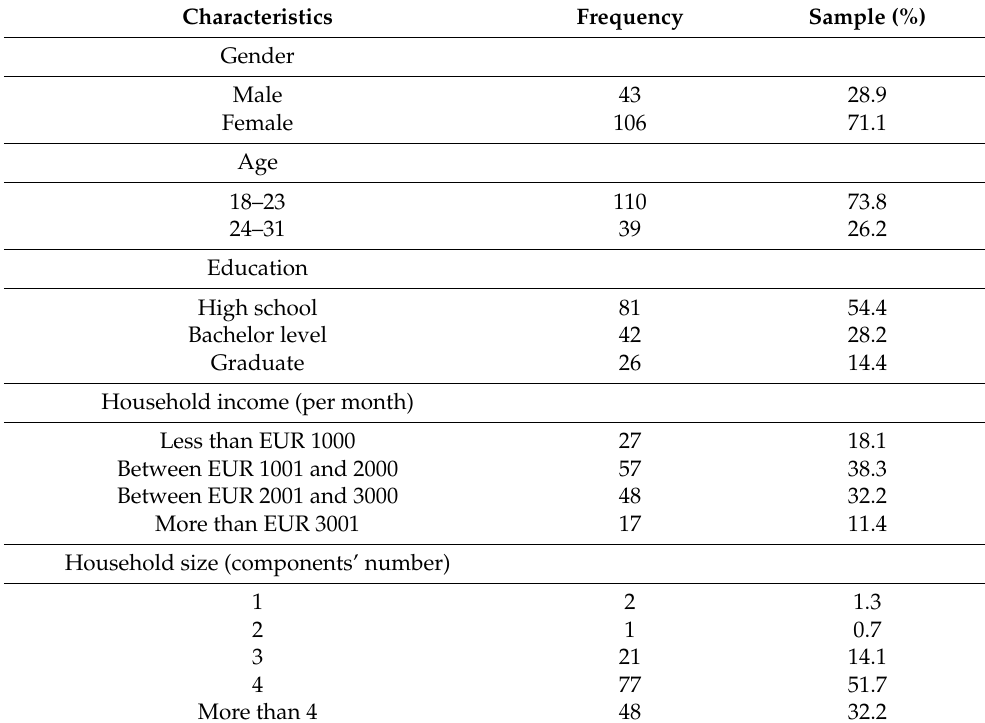
Table 1. Descriptive statistics of the sample.